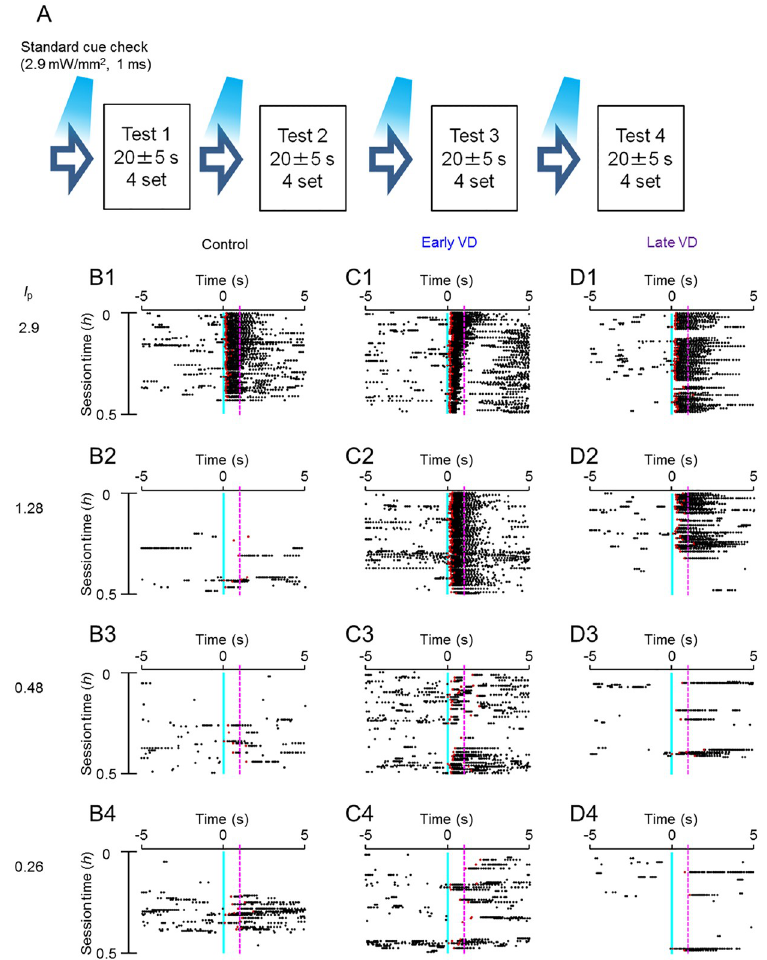
Fig 3. Near-threshold task performance under test 1 (fixed LED duration at 1 ms). A . Schema of the near-threshold task. B1-4 , Sample raster plots of the licking events of a control rat before and after 5 s of the onset of LED cues (blue vertical line) with a fixed LED pulse duration ( t p , ms) at 1.0 while decreasing the power ( I p , mW/mm 2 ) from 2.9 (B1), 1.28 (B2), 0.48 (B3) to 0.26 (B4). C1-4 , Similar to B1-4, but of an early VD rat. D1-4 , Similar to B1-4, but of a late VD rat. In B1-4, C1-4 and D1-4, each magenta broken line was drawn at 1 s after the cue